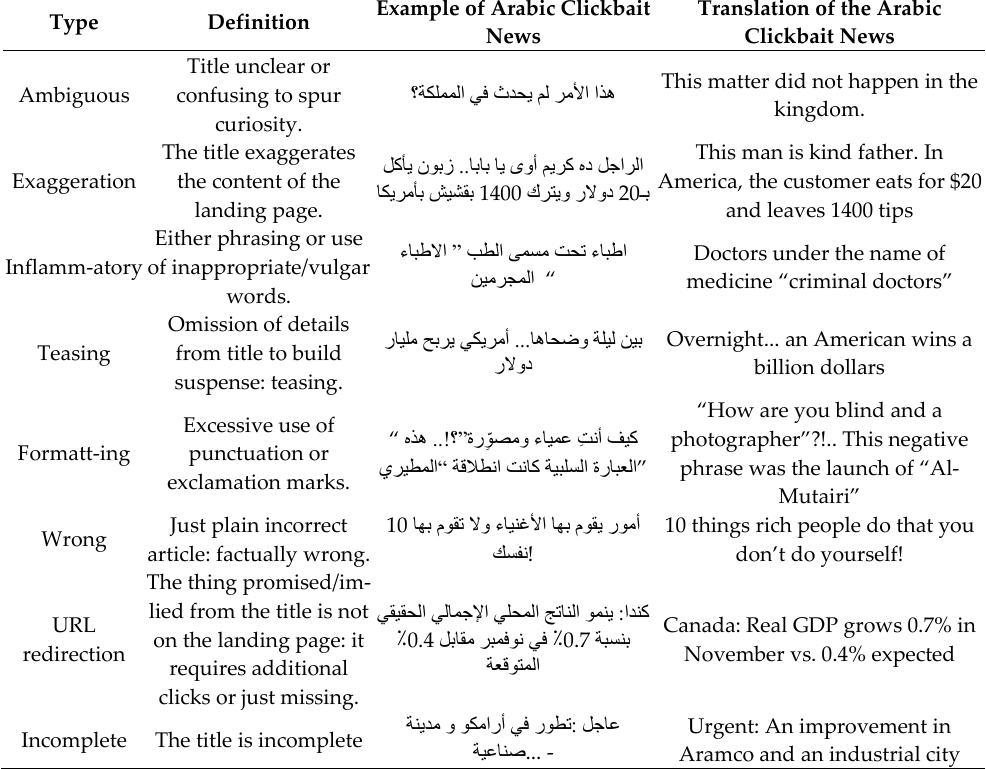
Table 4. Example of clickbait news.